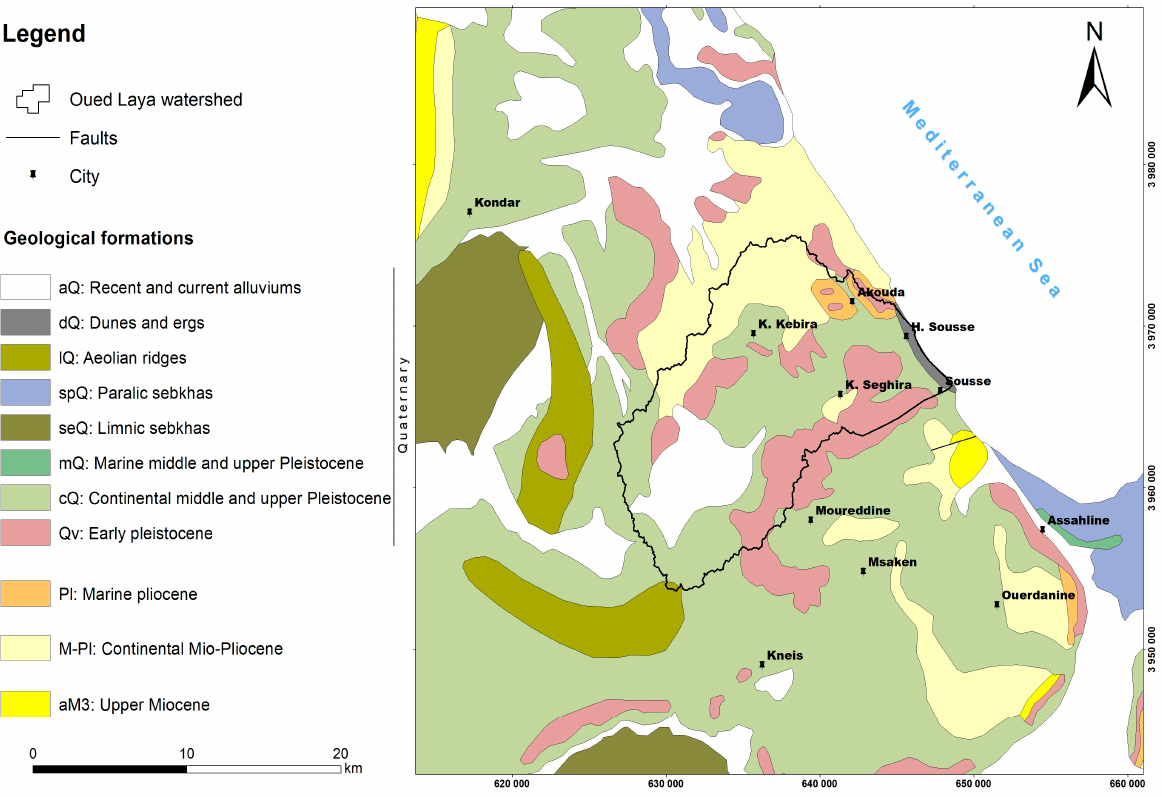
Figure 2. The outcropping geological formations in the Oued Laya watershed,